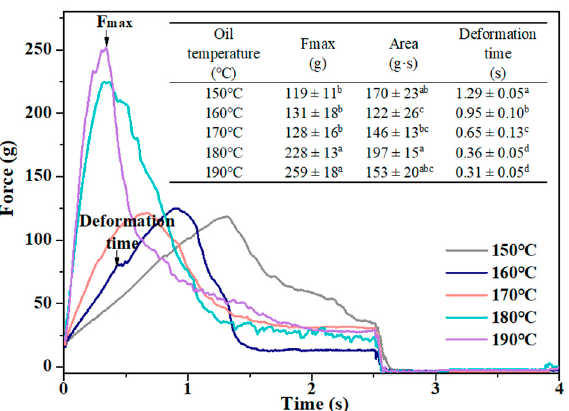
Figure 7. Effect of frying temperature on the texture of French fries. Different letters (a–d) indicate significant differences ( p ≤ 0.05).